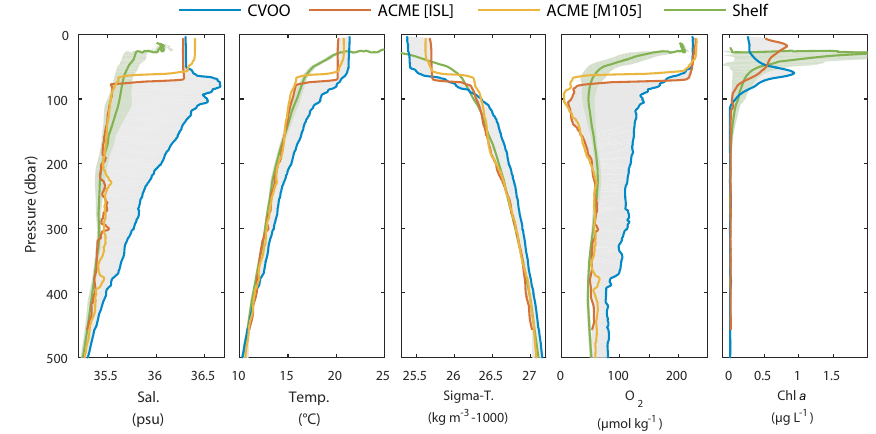
Figure 3. Vertical profiles for all parameters measured from sensors mounted on CTD rosette systems. Data from the nearby CVOO station (blue) represent local background conditions, the gray area emphasizes the local anomaly against the background introduced by the ACME (yellow and red) and the green curve represents mean initial conditions of the ACME at the shelf (light green indicates standard deviation of the mean profile). Note that not all surveys were carried out with the same sensor